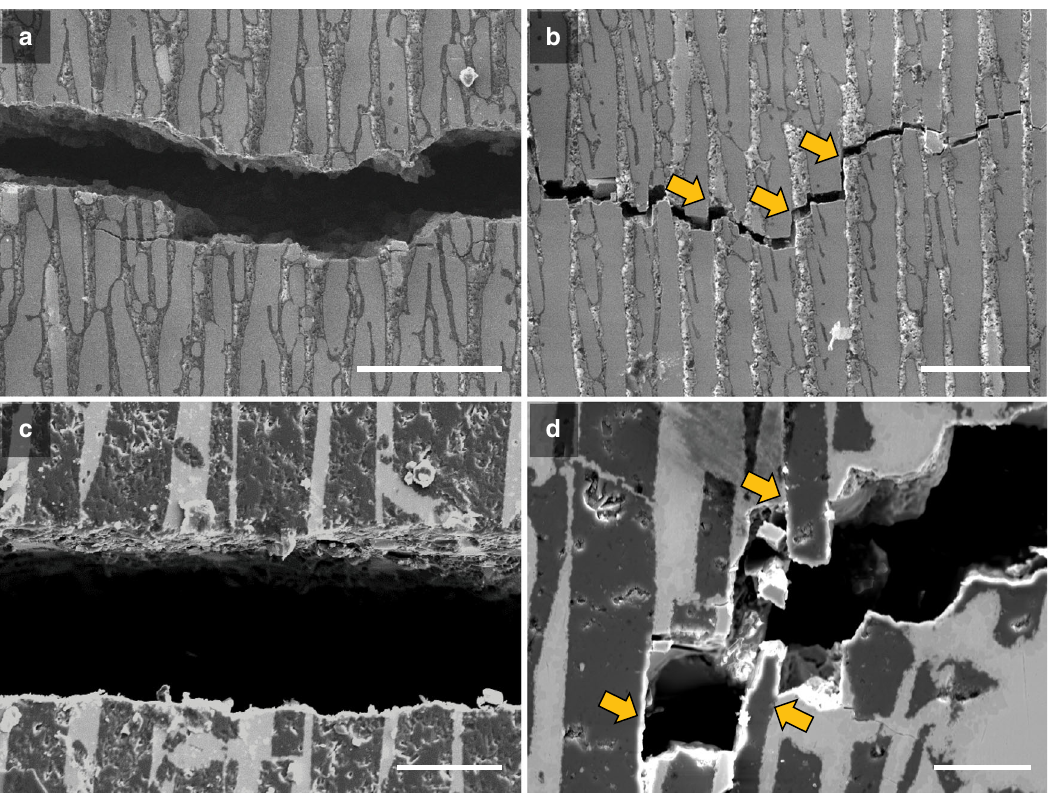
Fig. 8 SEM micrographs of crack patterns of the in fi ltrated alumina/BMG-forming materials samples. a – d Lamellar ( a , b ) and brick-and-mortar ( c , d ) samples in fi ltrated at 1153 K show little to no crack de fl ection behavior, in contrast to the corresponding samples in fi ltrated at 1273 K which exhibit crack de fl ection due to crack propagation along the interface of the ceramic and metallic components, which in turn leads to ceramic brick pullout and hence extrinsic toughening from crack bridging. The arrows highlight where the cracks propagated along the interface of the ceramic and metallic phases. This behavior is critical for stable crack-growth behavior and increases the crack-growth fracture toughness in the brick-and-mortar samples primarily due to crack bridging; however, superior damage tolerance would be generated if the inter-ceramic brick displacements occurred within the metallic mortar, rather than involving ceramic/metal interface failure. Scale bars: 100 μ m ( a , b ), 50 μ m ( c ) , and 30 μ m ( d